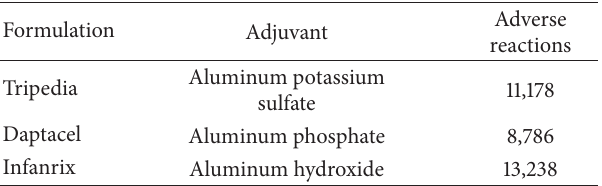
Table 6: Three different formulations of the DTaP vaccine and the number of reported adverse reactions available from VAERS for each